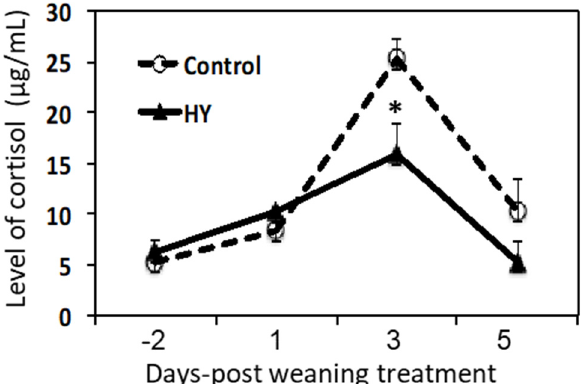
Figure 1. Changes in the serum cortisol levels of the calves fed the CON and HY calf starters after weaning. The dotted line represents the calves fed calf starter without HY (control diet (CON)) and the solid line represents the calves fed calf starter supplemented with hydrolyzed yeast (HY). Blood cortisol levels were assessed via an ELISA assay. The asterisk indicates a significant difference between the dietary groups ( p < 0.05). Data are presented as the mean ± SE. Day 0 post-weaning represents the beginning of the weaning procedure (42 days of age).